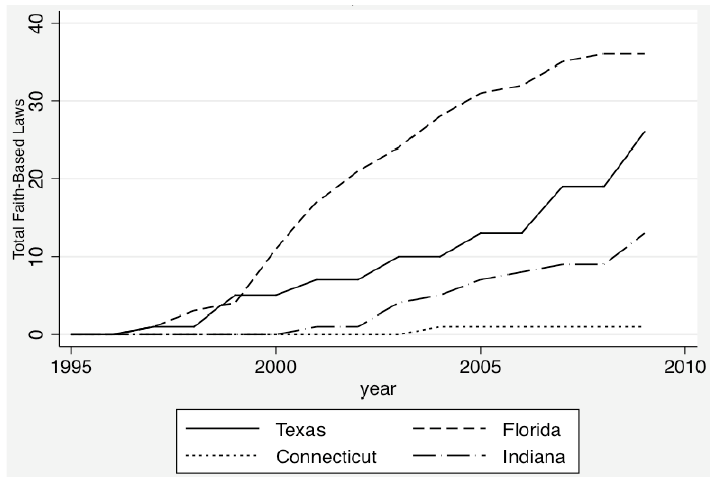
Figure 3. Cumulative count of faith ‐ based legislation for selected states, 1995–2009.